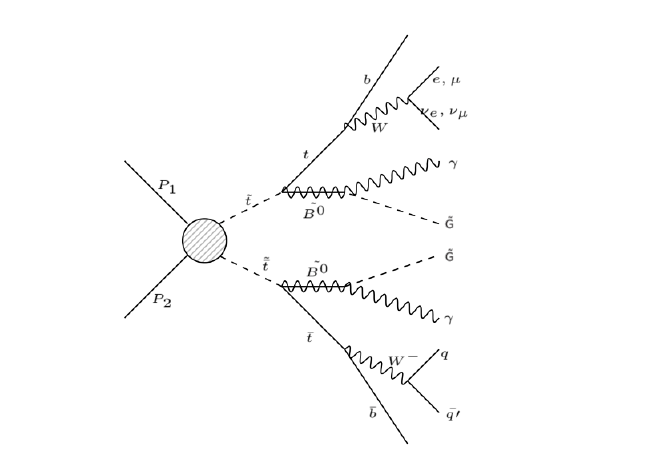
Figure 1 . The event topology used to search for low mass top squarks